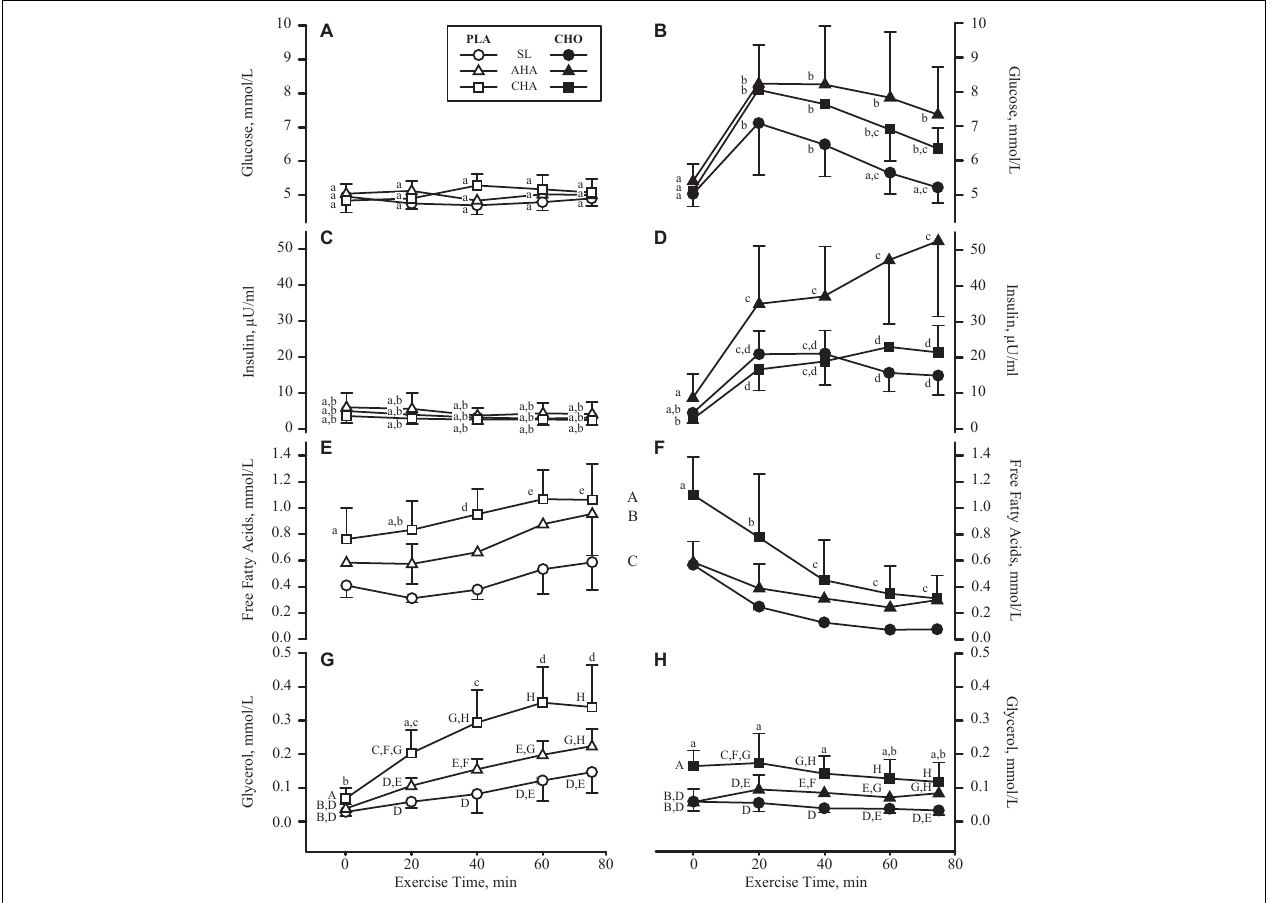
FIGURE 5 | Mean + SD of serum concentrations of glucose (mmol/L, A,B ), insulin ( µ U/mL, C,D ), free fatty acids (mmol/L, E,F ) and glycerol (mmol/L, G,H ) concentrations in participants provided non-nutritive placebo (PLA, n = 6, open symbols, left column of panels) or 1.8 g/min carbohydrate (CHO, n = 8, 65.25 g fructose + 79.75 g glucose, closed symbols, right column of panels) during 80-min steady-state exercise (treadmill walking) at sea level (SL) and at 4,300 m altitude, within 5–7 h after arrival (acute high-altitude, AHA) and again on the 22nd day of continuous residence at high-altitude (chronic high-altitude, CHA). For glucose and insulin, points not sharing the same lower case letter are different (treatment by phase by time interaction, P < 0.05 for both metabolites). For free fatty acids, time points not sharing the same lower case letter are different (treatment by time interaction, P < 0.05), and phases not sharing same upper case letter are different (main effect of phase, P < 0.05), no interactions). For glycerol, time points not sharing the same lower case letter are different (treatment by time interaction, P < 0.05) and time points not sharing the same upper case letter are different (time by phase interaction, P <